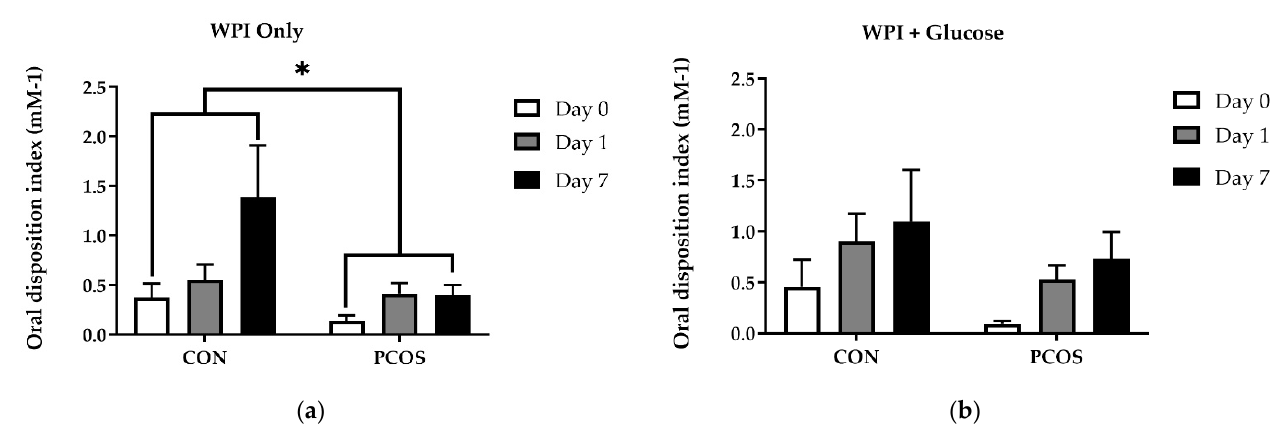
Figure 7. DI O mean values (±SE) in CON ( n = 15) and PCOS ( n = 14) 30 min after ( a ) WPI ingestion and ( b ) glucose ingestion. DI O for WPI ingestion only, showed no interaction effect of group and day but did indicate the main effects of group ( p = 0.028) and day (0.015). DI O after glucose ingestion, yielded no significant interaction or main effects. * = significance between groups, p < 0.05. CON = non-PCOS women; DI O = Oral Disposition Index; PCOS = women with polycystic ovarian syndrome.